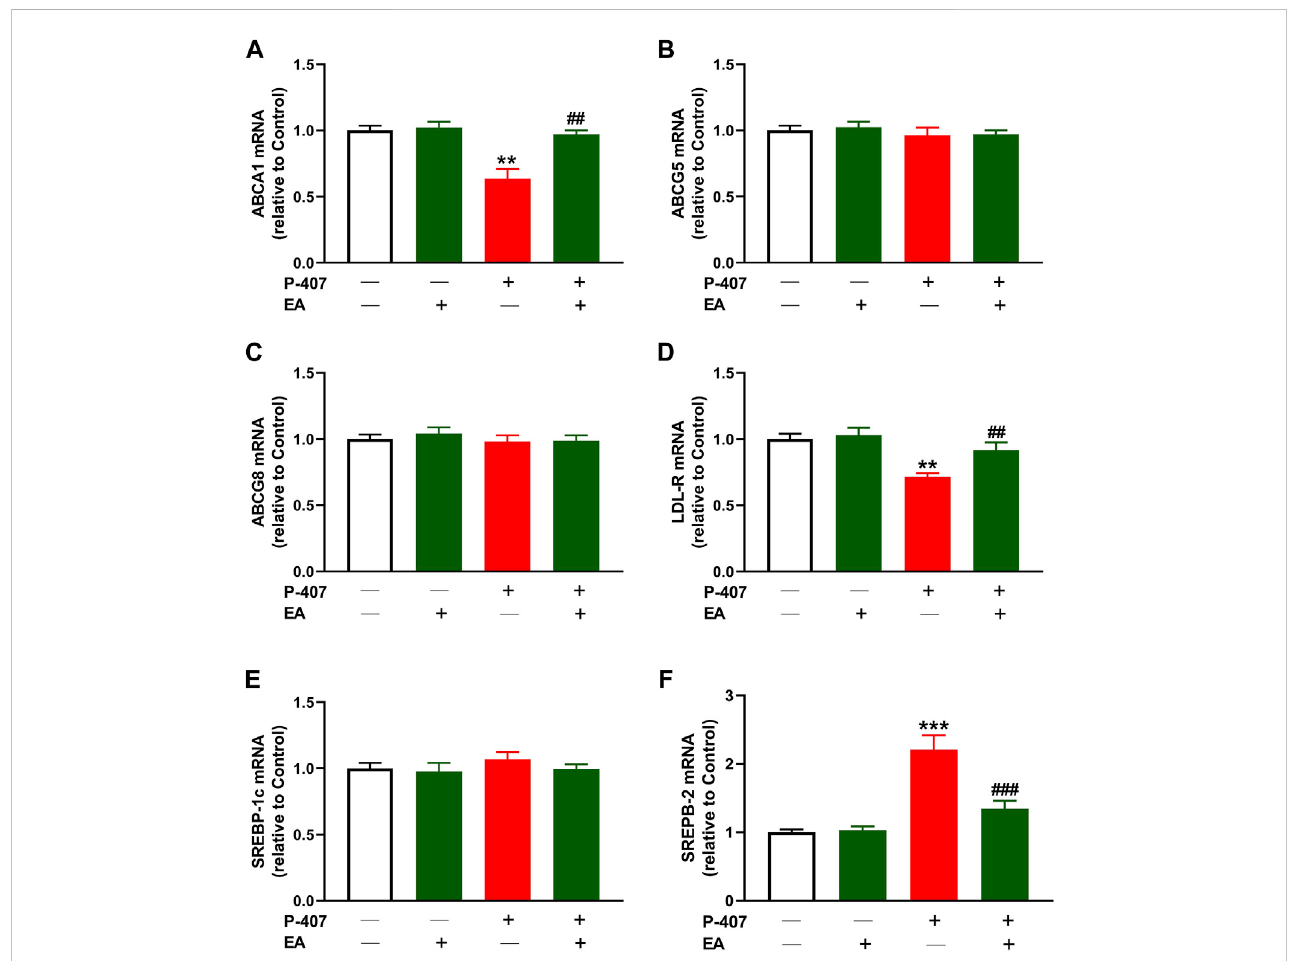
FIGURE 10 Effect of the ethyl acetate fraction on (A) ABCA1, (B) ABCG5 (C) ABCG8, (D) LDL-R (E) SREBP-1, and (F) SREBP-2 in P-407-administered rats. Values are represented as mean ± SEM ( n = 6). ** p < 0.01 and *** p < 0.001 versus Control. ## p < 0.01, and ### p < 0.001 versus